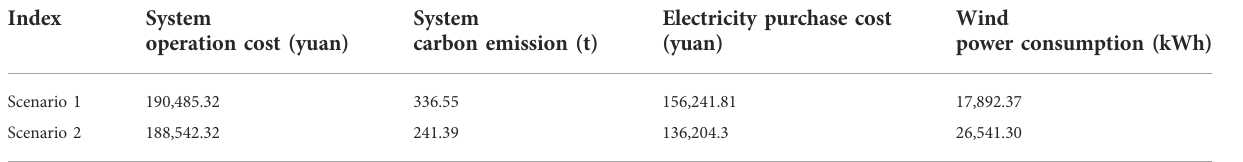
TABLE 4 Comparison of system operation bene fi ts in different